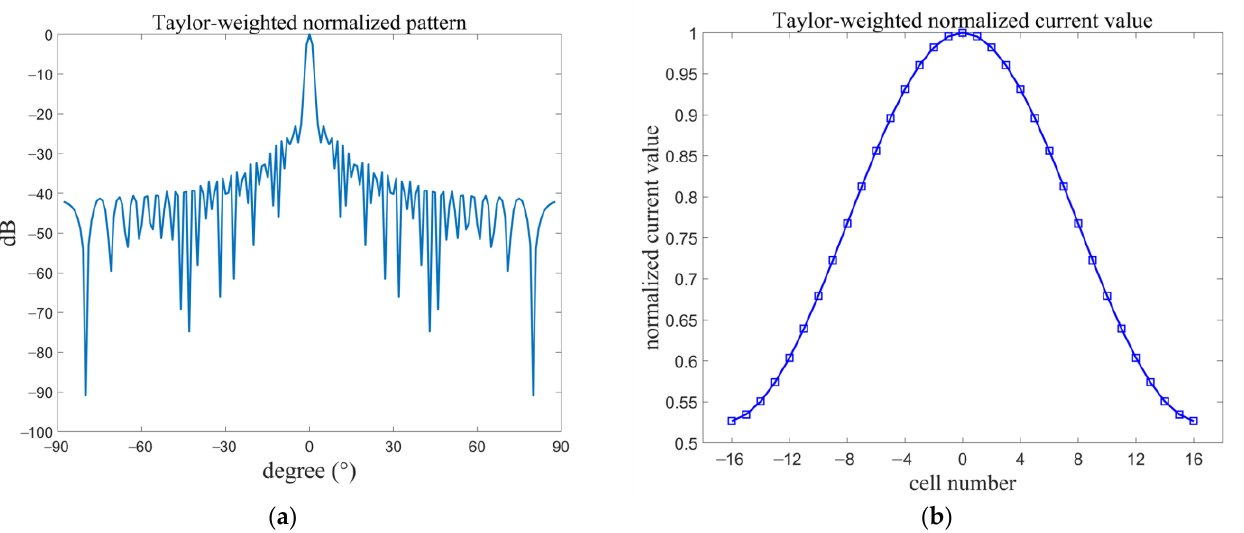
Figure 1. ( a ) Pattern of 33-cell array antenna by Taylor synthesis; ( b ) current distribution of every cell by Taylor synthesis.